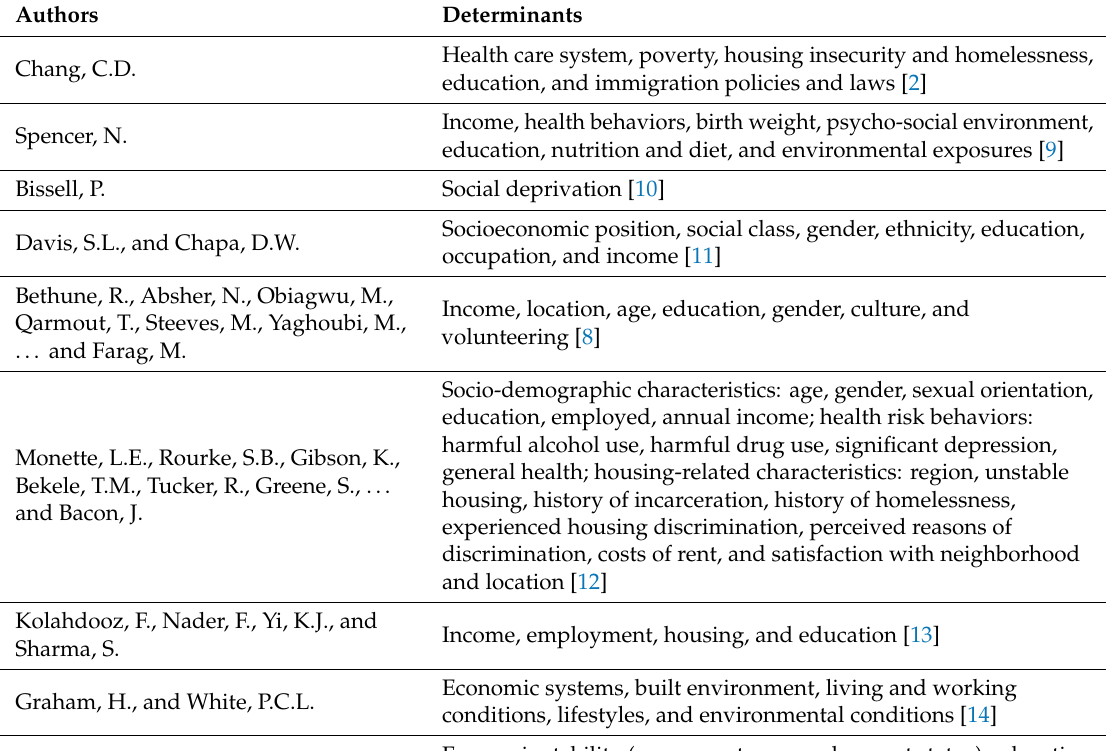
Table 1. Social determinants of health in selected previous